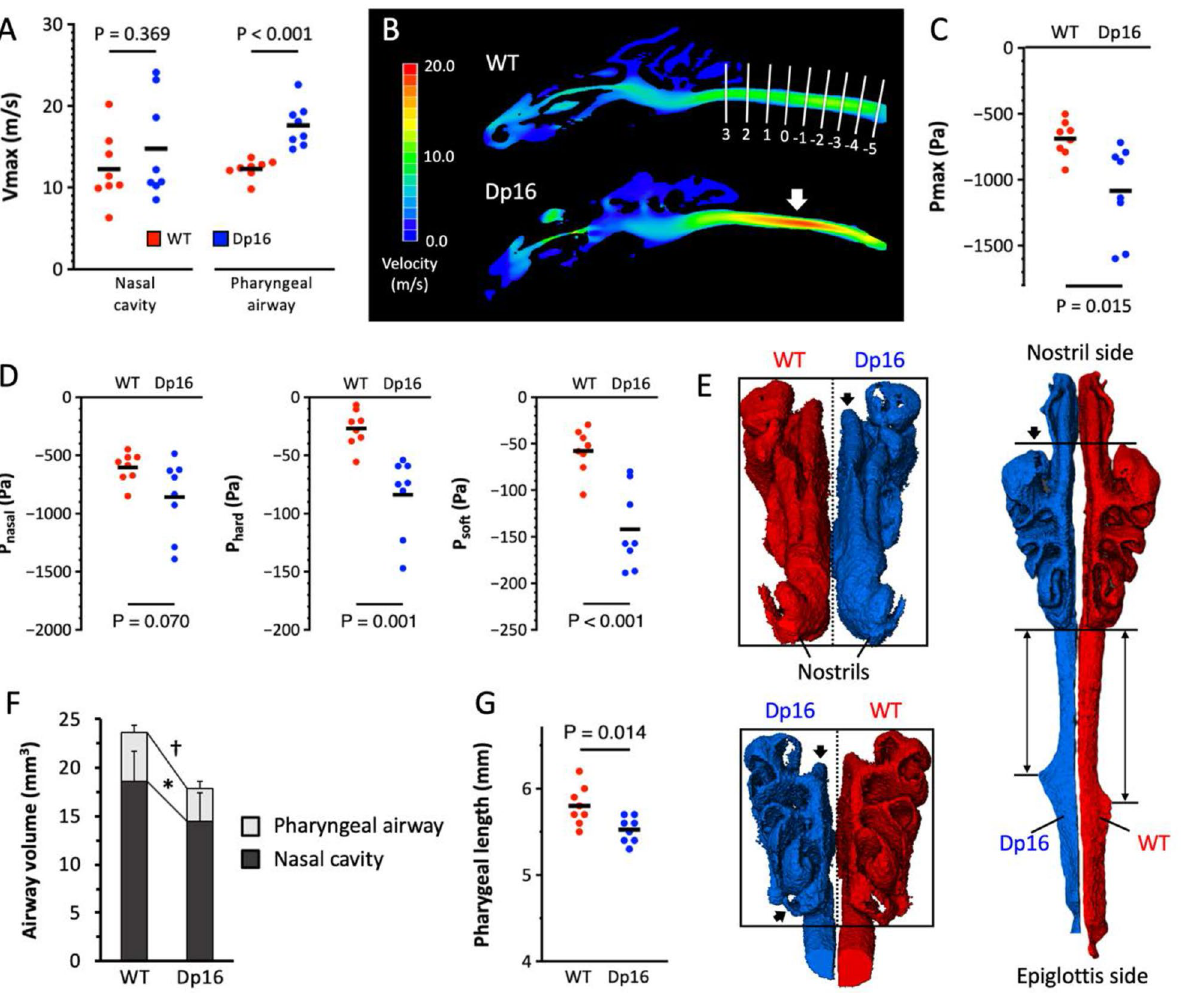
Figure 5. Airflow analyses using computational fluid dynamics. ( A ) Statistical comparisons of the Vmax in the nasal cavity and pharyngeal airway are shown. ( B ) The sagittal slices of the velocity analysis obtained from a representative mouse of each genotype illustrate a notable acceleration in the pharyngeal airway of the Dp16 mouse (46-day-old, male WT mouse weighing 22.7 g vs. 47-day-old, male Dp16 mouse weighing 22.5 g). The location of the highest velocity corresponds with the narrowest part of the upper airway (arrow). White solid lines indicate same lines shown in Fig. 3. ( C ) The Pmax was estimated at the level of the epiglottis. Dp16 mice had a significantly higher negative pressure in comparison with WT mice. ( D ) The upper airway was divided into 3 segments based on its surroundings and multilevel pressure drops (P nasal , P hard , and P soft ) were assessed. ( E ) The rostral, caudal, and dorsal views of the upper airway are shown. The left-sided upper airway shown in blue is from a Dp16 mouse (female; 69-day-old; body weight is 18.6 g) and the right-sided one shown in red is from a WT mouse (female; 60-day-old; body weight is 19.1 g). The dotted line is set at the midline of the two and the size of the boxes surrounding the airway matches the upper airway of the WT mouse for ease of visual comparison. The Dp16 mouse has a dorsoventrally smaller and horizontally thinner nasal cavity (black arrows) and a shorter pharyngeal airway (double arrows). ( F ) The volume of the nasal cavity and pharyngeal airway is compared between genotypes. ( G ) Dp16 mice have a significantly shorter pharyngeal airway than WT mice. Values are presented as means ± SD. * P < 0.05; † P <